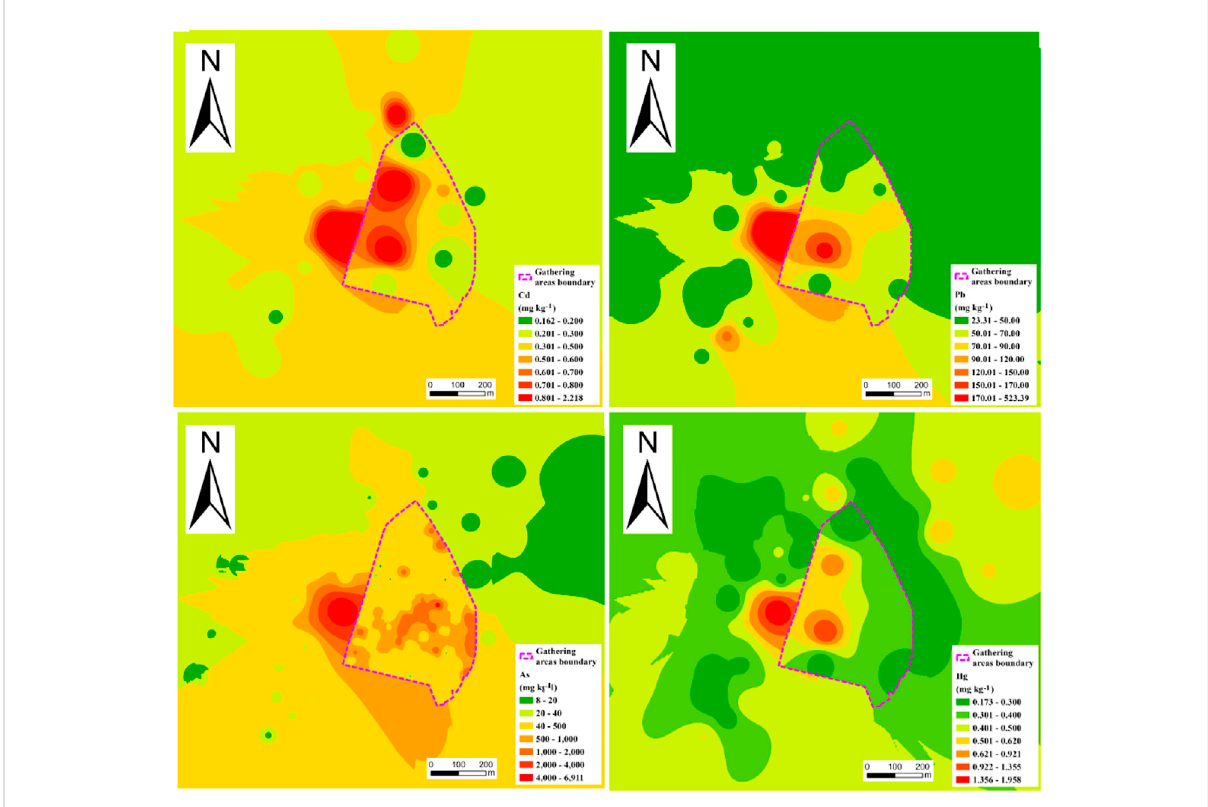
FIGURE 7 Distribution of heavy metal concentrations in pharmaceutical plant cluster and surrounding farmland.